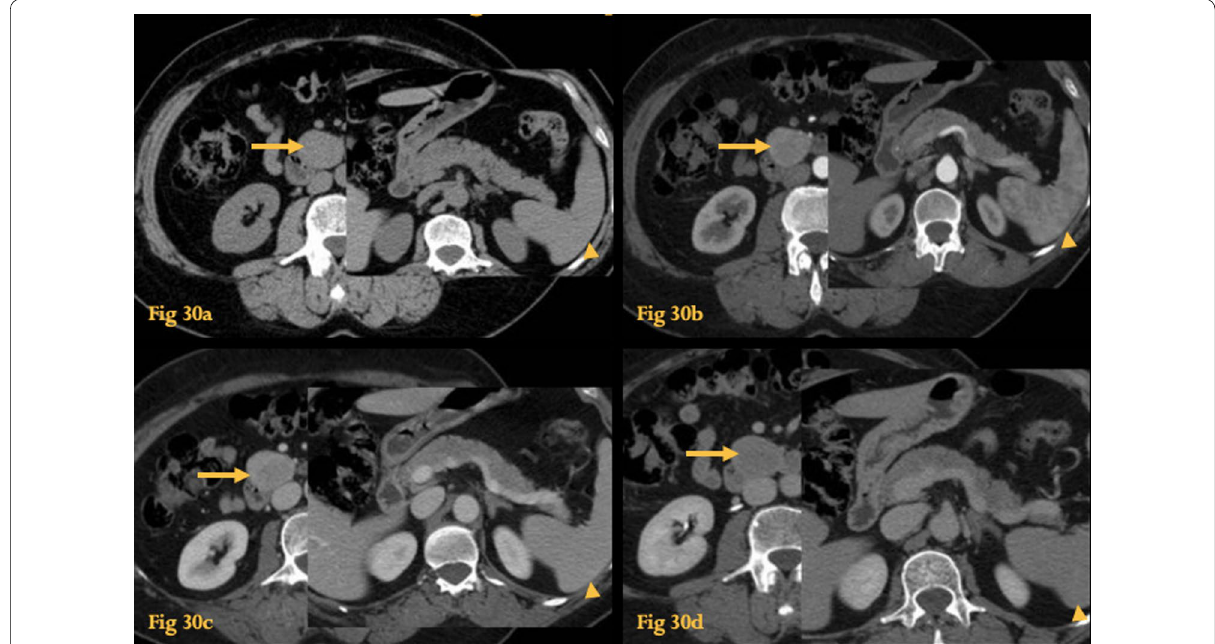
Fig. 30 Accessory Spleen. Unenhanced ( a ), arterial phase ( b ), portal venous phase ( c ), and late phase acquisitions ( d ) CT show fortuitus finding of a peri‑duodenal solid lesion, between the uncinate process and the third portion of the duodenum (arrows), with a smooth, round shape, and a pattern of enhancement similar to the normal spleen (arrowheads) on all phases. Histopathological study of the resected surgical specimen revealed splenic